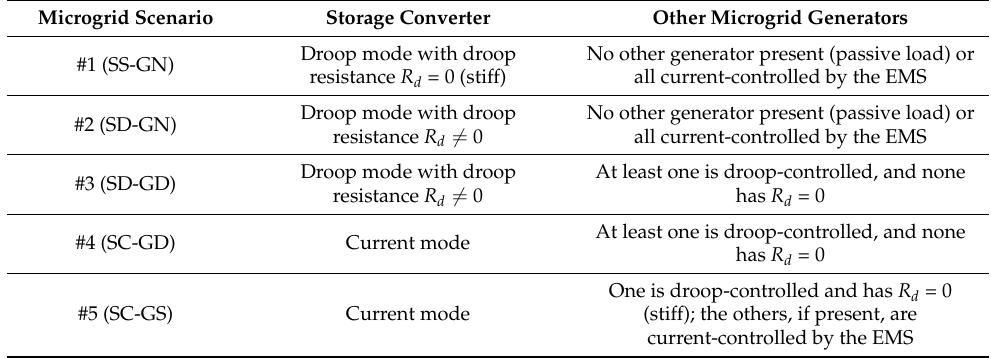
Table 3. Possible DC microgrid scenarios.